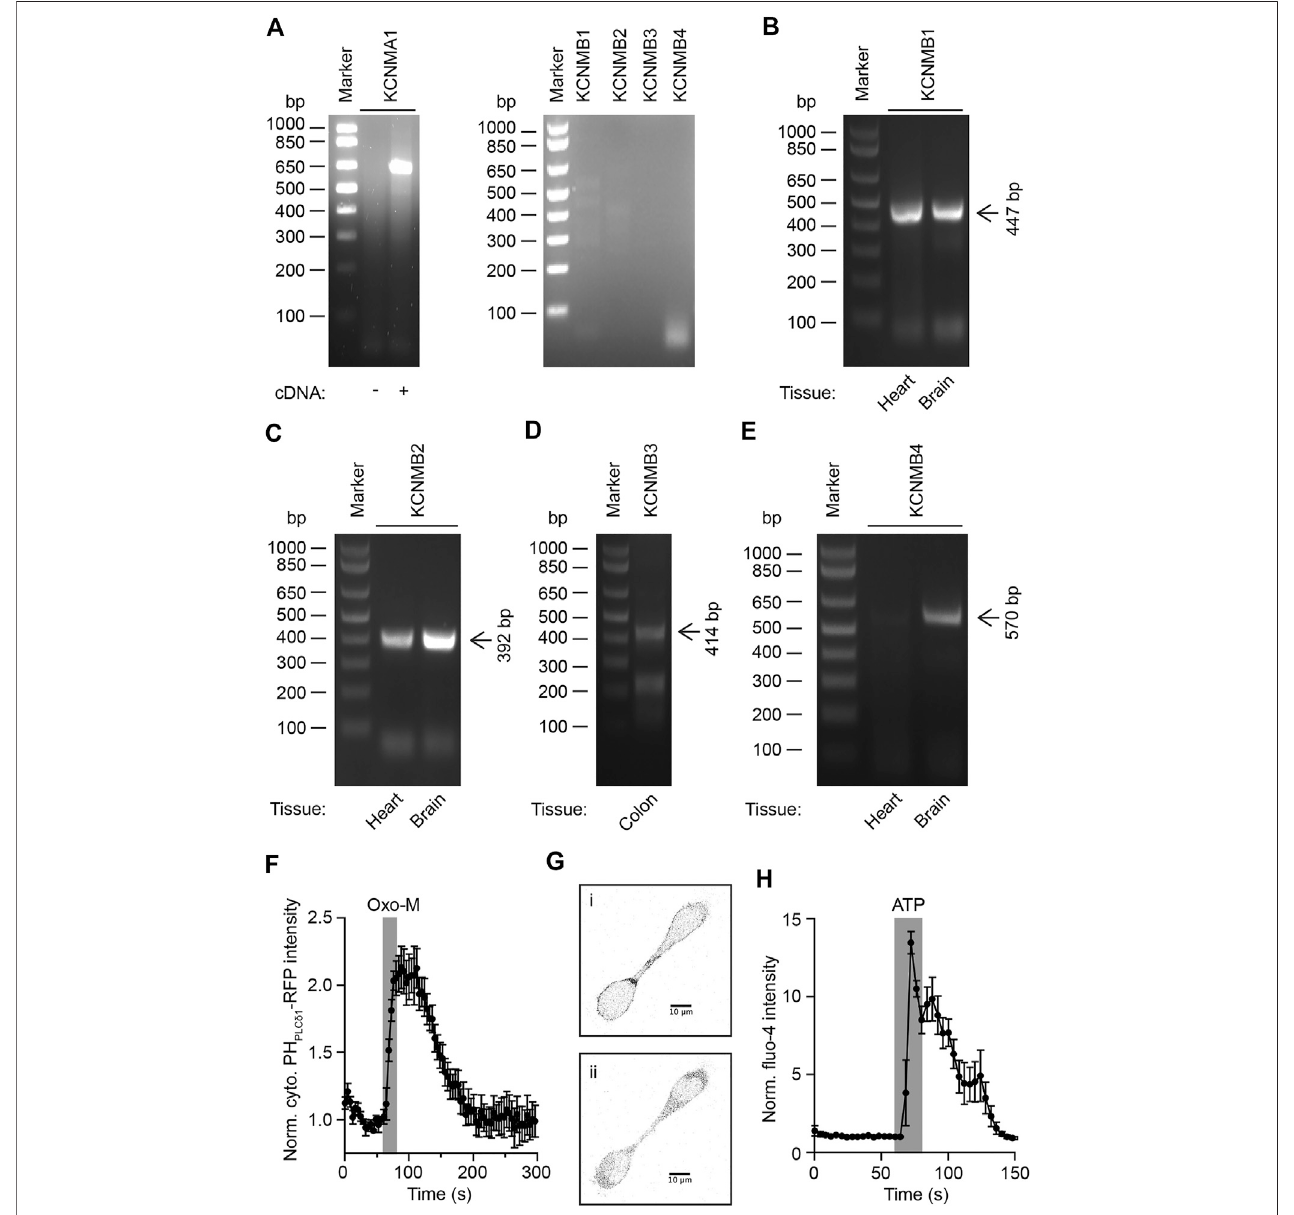
FIGURE 1 | Expression analysis of KCNMA1 channel complexes in rat superior cervical ganglion neurons. ( A) Left: RT-PCR on cDNA generated from total RNA isolatedfromratSCGwitholigonucleotidesforKCNMA1channel α -subunit. Right: Sameasonleft,butwitholigonucleotidesforKCNMA1channel β -subunits. (B) - (E) . RT-PCRoncDNAgeneratedfromtotalRNAisolatedfromindicatedrattissueswitholigonucleotidesforindicatedKCNMBsubunits.Arrowsindicateexpectedmolecular weight for PCRfragments. (F) . Normalized cytoplasmicRFP-intensityin HEK293 cells expressing PH PLC δ 1 -RFP and mouse M 1 Rin response to stimulation of cells with 10 μ M Oxo-M ( n (cid:2) 5). Error bars indicate SEM. Traceswere normalized to the last timepoint before application of Oxo-M. (G) . Representative gray-scale imagesof HEK293 cells expressing PH PLC δ 1 -RFP before 1) and after 2) activation of muscarinic acetylcholine receptors by 10 μ M Oxo-M. (H) . Normalized fl uo-4 intensity in HEK293cellsinresponsetostimulationofcellswith100 μ MATP( n (cid:2) 6).ErrorbarsindicateSEM.TraceswerenormalizedtothelasttimepointbeforeapplicationofATP.